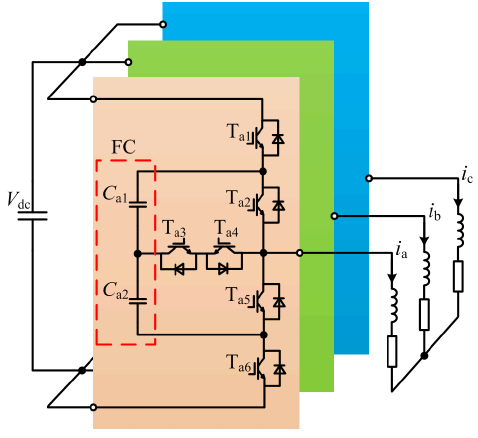
Figure 14. The topology of the four-level inverter.